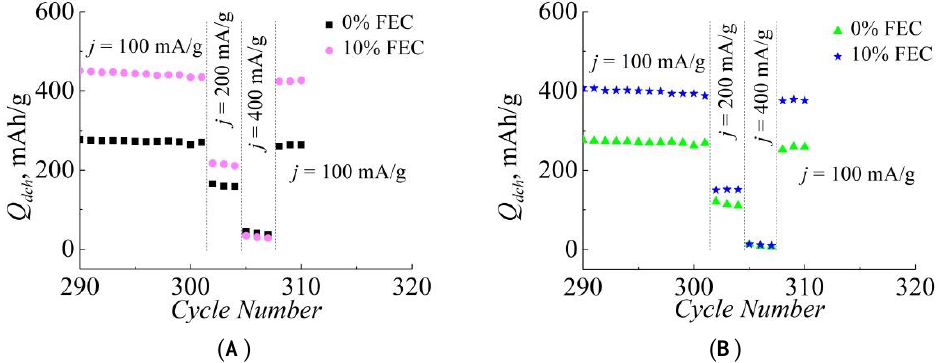
Figure 6. The result of recharging with increased currents after the 300th cycle for the samples in pairs ( A , B ).